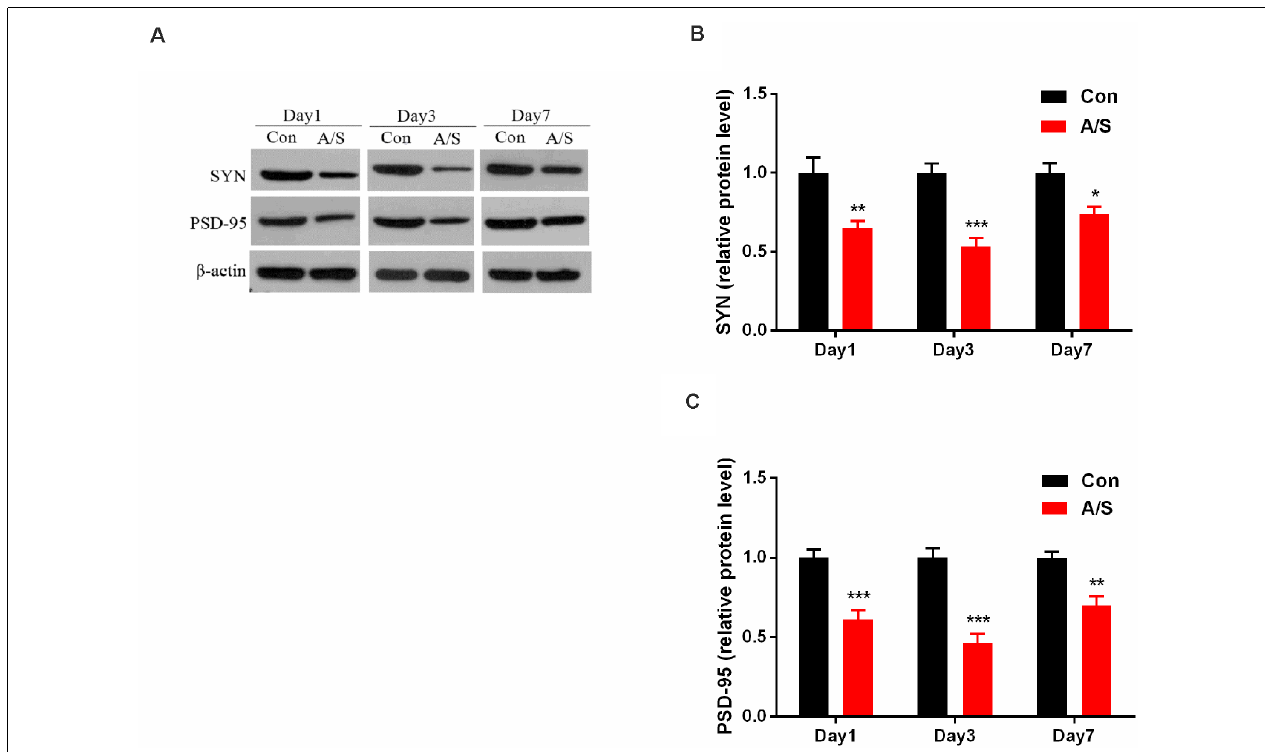
FIGURE 3 | Anesthesia and surgery decreased synaptophysin (SYN) and postsynaptic density protein 95 (PSD-95) levels in the hippocampus. (A) Representative western blot illustrating SYN and PSD-95 levels in the hippocampus on days 1, 3 and 7 after anesthesia/surgery. (B,C) Anesthesia/surgery reduced SYN and PSD-95 expression in the hippocampus on days 1, 3 and 7 after anesthesia/surgery. Data are mean ± SEM ( n = 6 per group). *** p < 0.001, ** p < 0.01, * p < 0.05 vs. Con. Con, control group; A/S, anesthesia/surgery